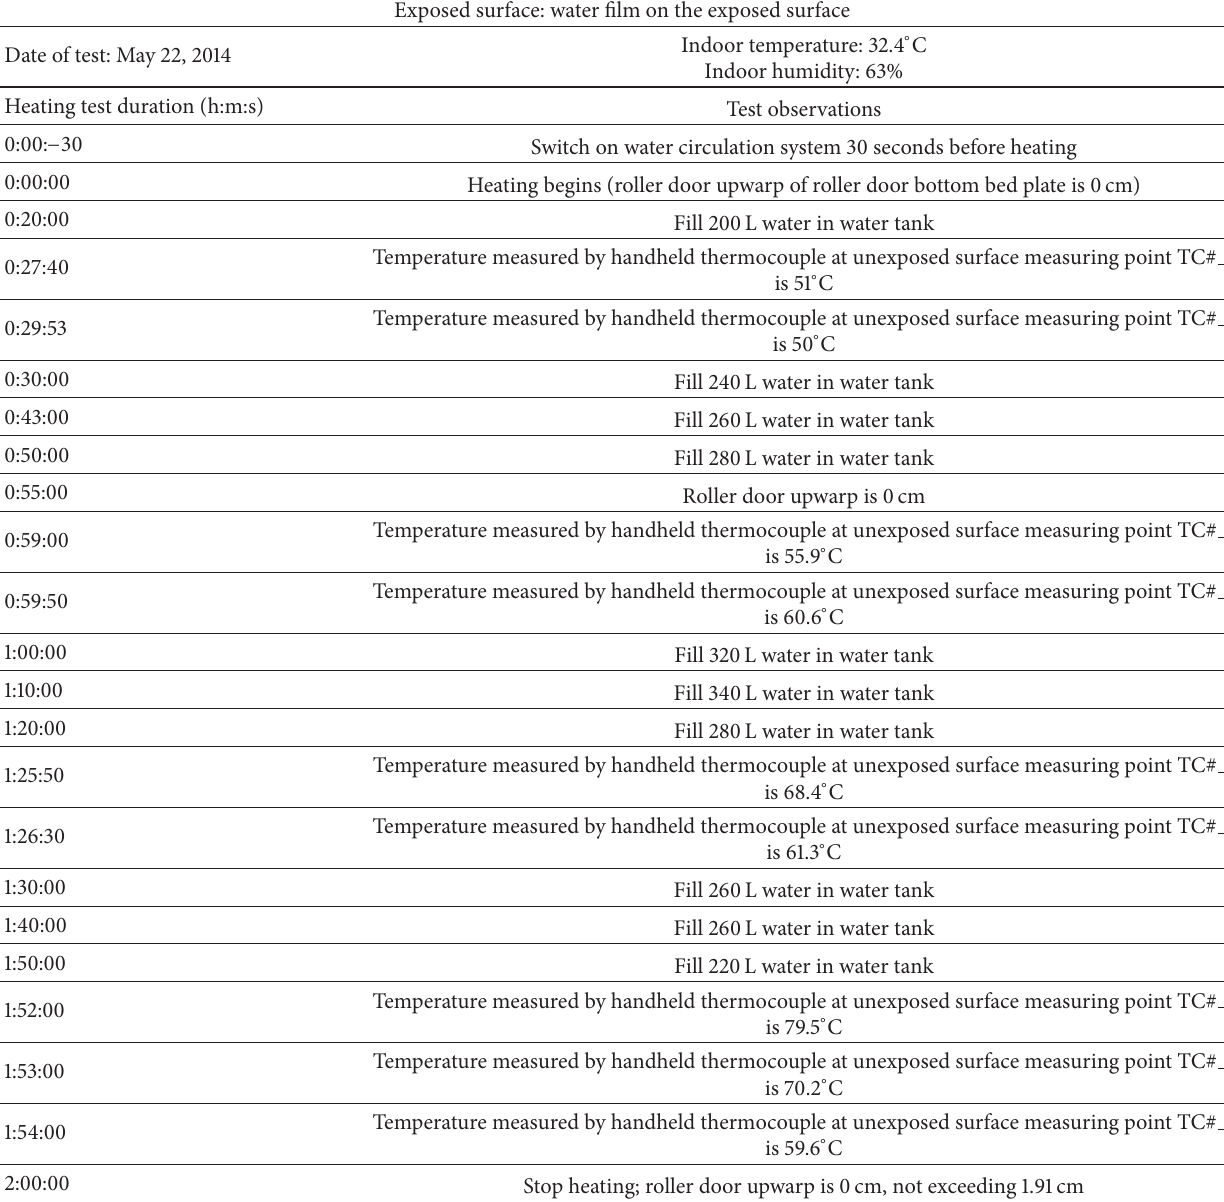
Table 2: Heating test record of high-speed roller door with water film on exposed surface. Exposed surface: water film on the exposed